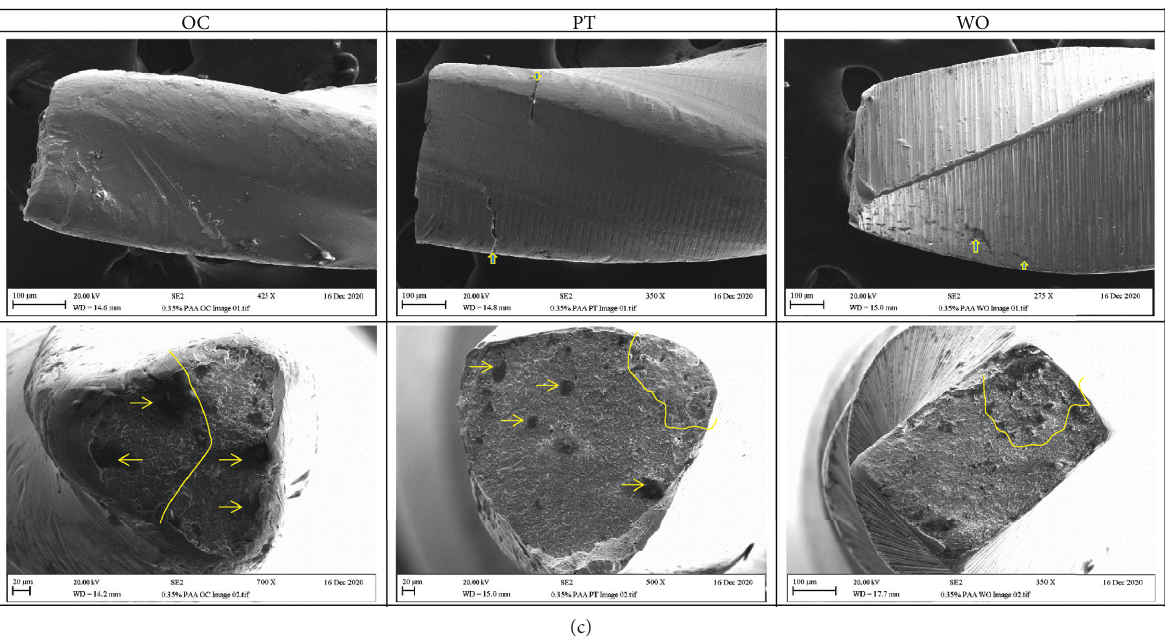
Figure 3: Scanning electron micrographs of failed files: (a) control subgroups, (b) 0.002% PAA subgroups, (c) 0.35% PAA subgroups showing the lateral view of the fractured files having numerous cracks near the fracture sites (thick arrows), with surface wear (erosion) of the cutting edges represented by short straight lines. The cross-sectional views of crack initiation areas (dotted line) and surface pitting with voids (thin